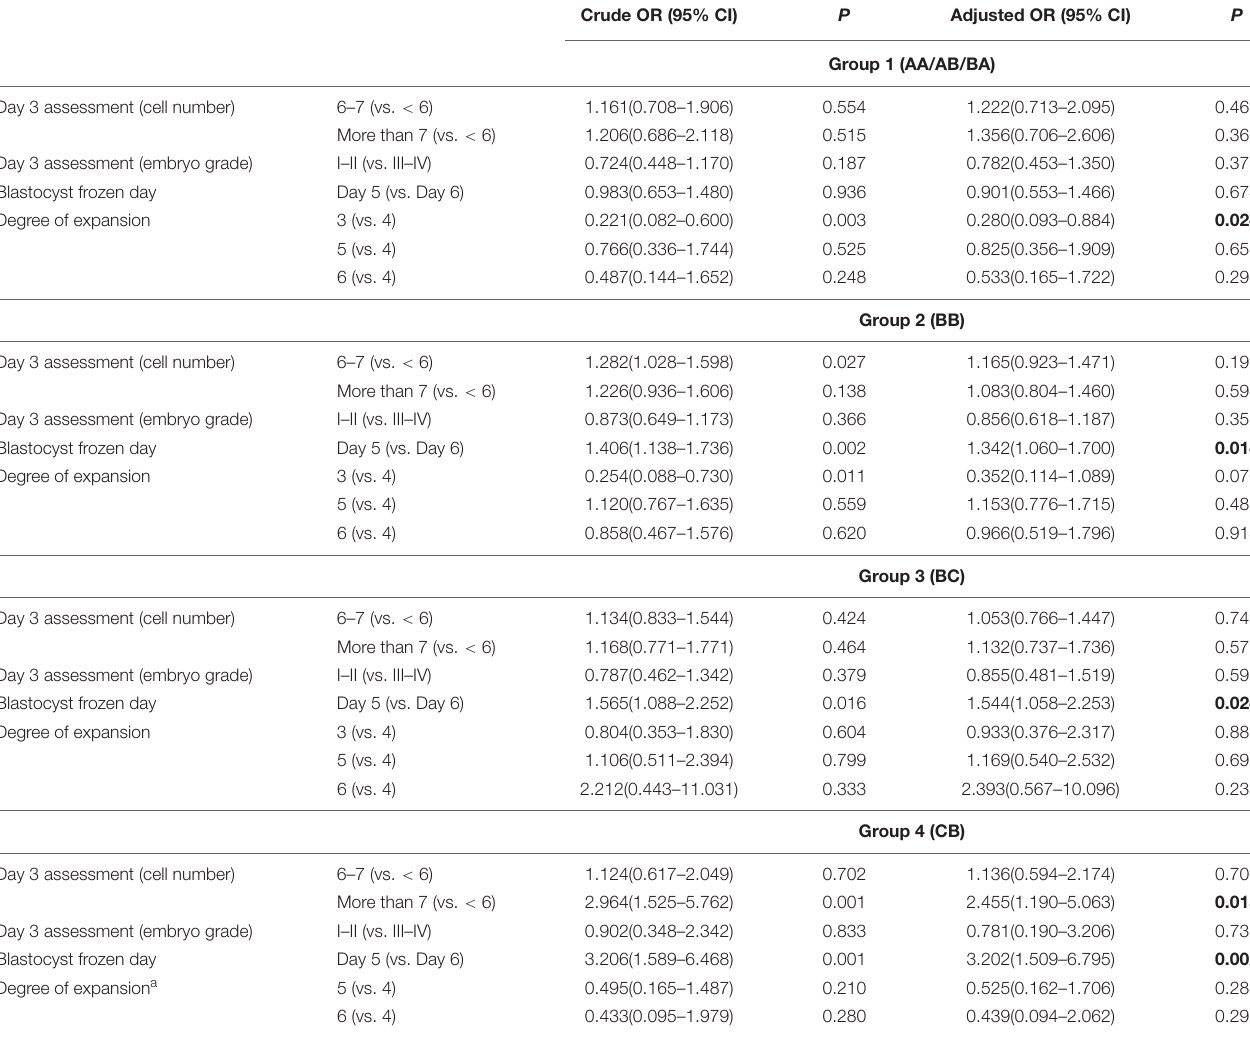
TABLE 2 | Crude and adjusted OR of live birth rate in different grade blastocysts.